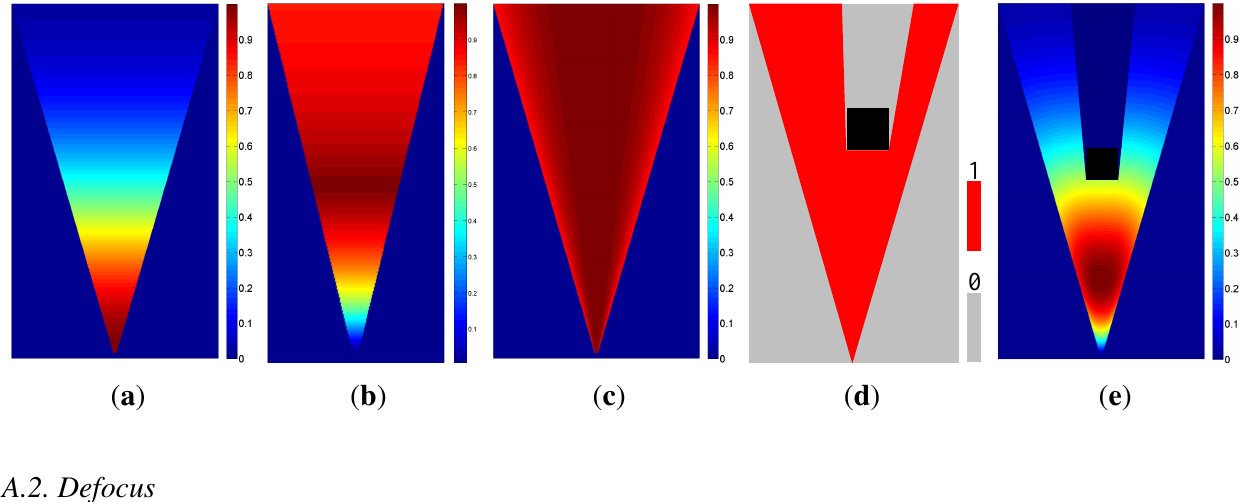
Figure 10. The distribution in the sensing field of the four considered components. (a) Resolution component. (b) Defocus component. (c) Geometric distortion component. (d) Occlusion effect caused by the obstacle. (e) Distribution of observation quality in the sensing field with